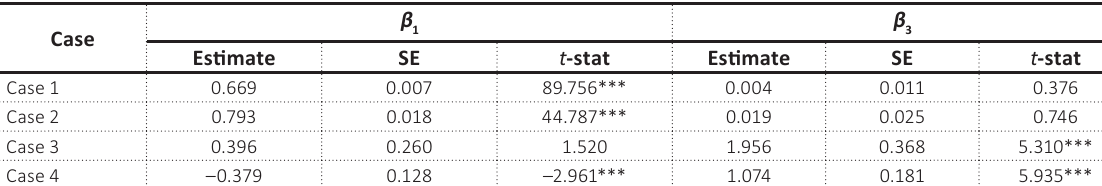
Table 3. QuTER and TER